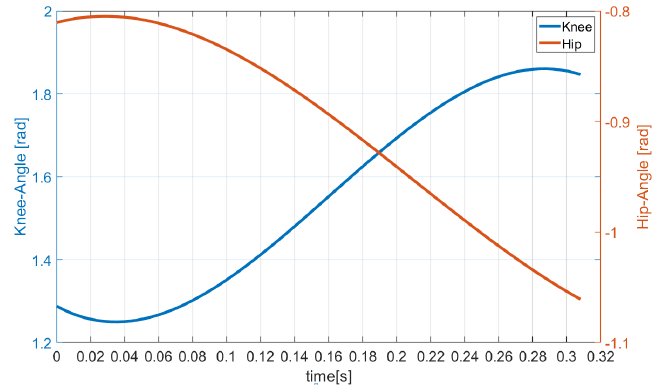
Figure 4. Trajectories of actuated joints in the flight phase.